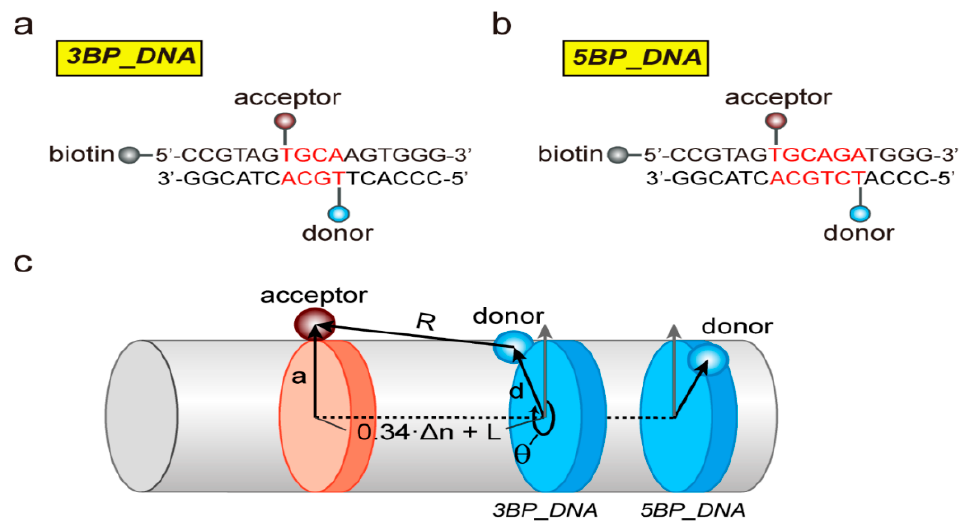
Figure 2. Structural model prediction for determining inter-dye distances. ( a , b ) DNA constructs, 3BP_DNA ( a ) and 5BP_DNA ( b ), used for the experiments. The labeling sites for conjugating donor and acceptor dyes are indicated. ( c ) Inter-dye prediction using cylindrical model for helical geometry of the double-stranded DNA used in measurements.